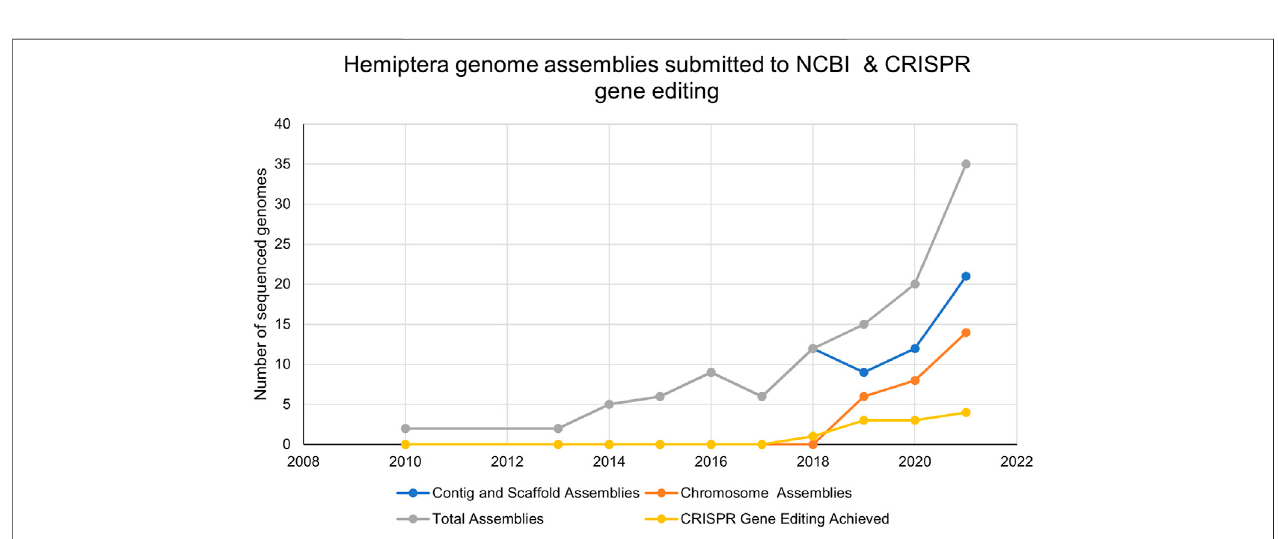
FIGURE 3 | The number of Hemiptera genome assemblies at the NCBI and the number of publications reporting CRISPR/Cas9 mutagenesis in Hemiptera from 2010 – 2021.